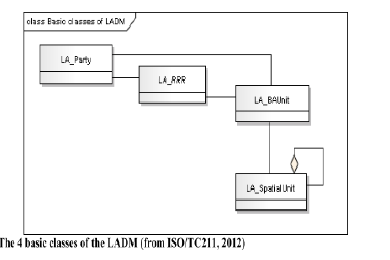
Figure 1. The LADM's four fundamental classes (ISO/TC211,